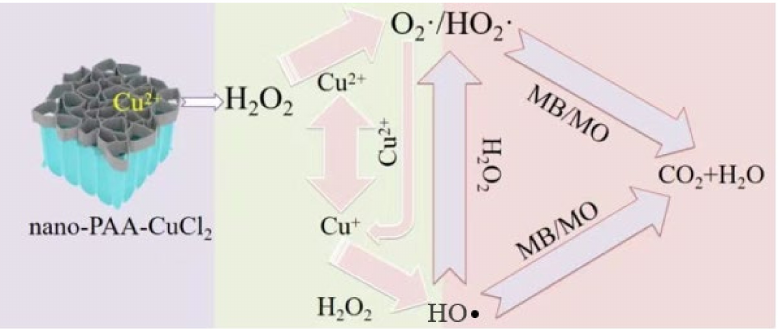
Figure 14. Schematic diagram of the mechanism of catalytic degradation of MB/MO by nano-PAA- CuCl 2 /H 2 O 2 system.